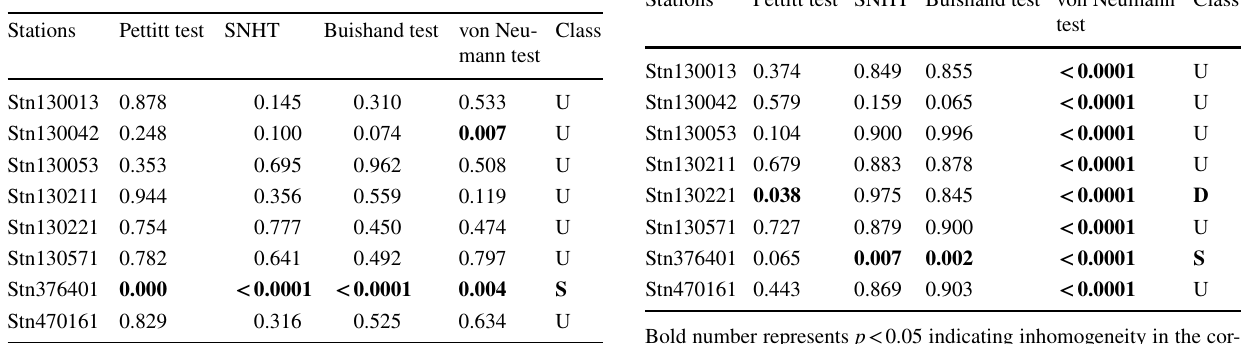
Table 7 The p values obtained from the homogeneity tests for the annual rainfall